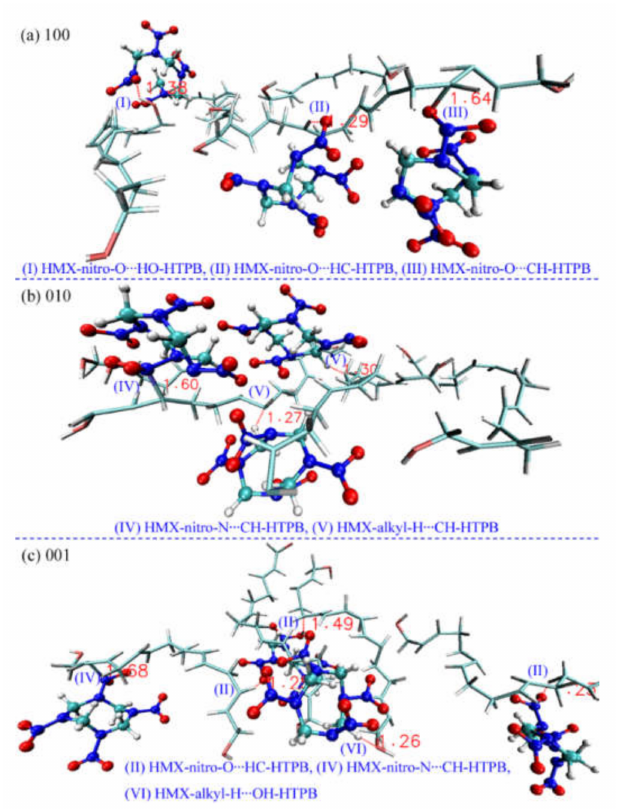
Figure 2. Mainly interaction patterns between HMX and HTPB molecules under shock